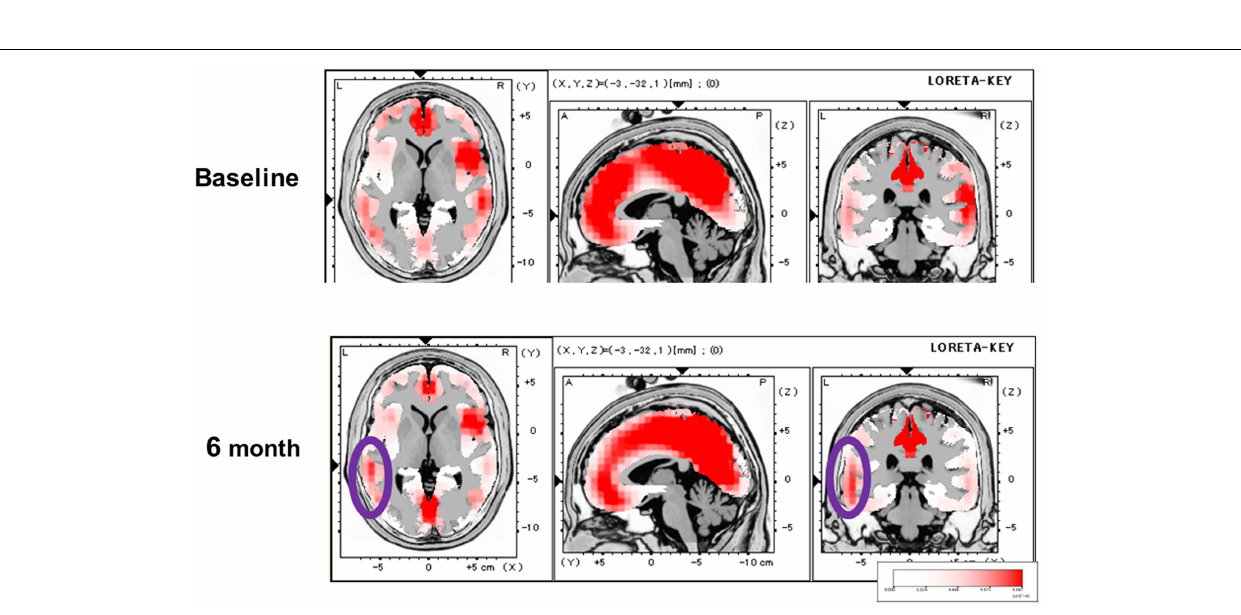
FIGURE 2 | P300 waveforms in response to olanzapine treatment (right) . P300 waveforms were averaged for 16 subjects per group. Black lines represent P300 activity for control subjects. Blue lines show P300 for patients at baseline, whose amplitudes are diminished compared to control